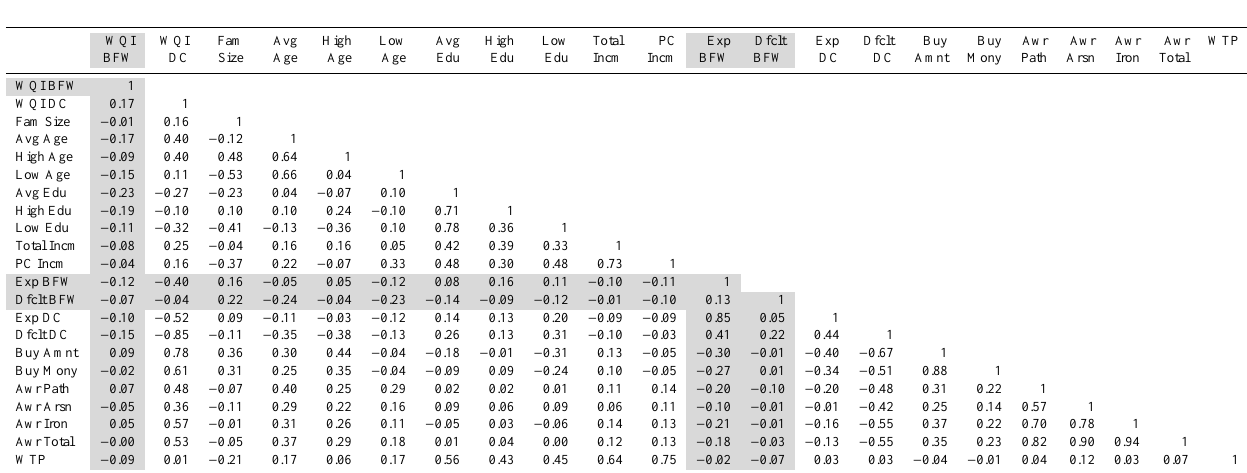
Table 5. Correlation